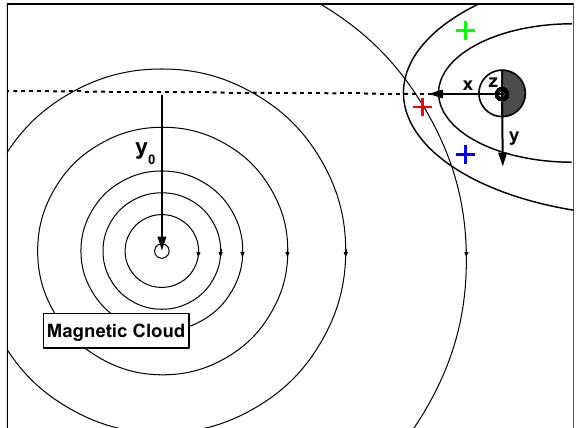
Fig. 5. Schematic of an MC’s interaction with Earth’s environment in our model in the ecliptic plane. The y 0 parameter corresponds to the distance between the intersection of the MC’s axis and the Sun– Earth line. The coloured crosses display the approximate location of the virtual